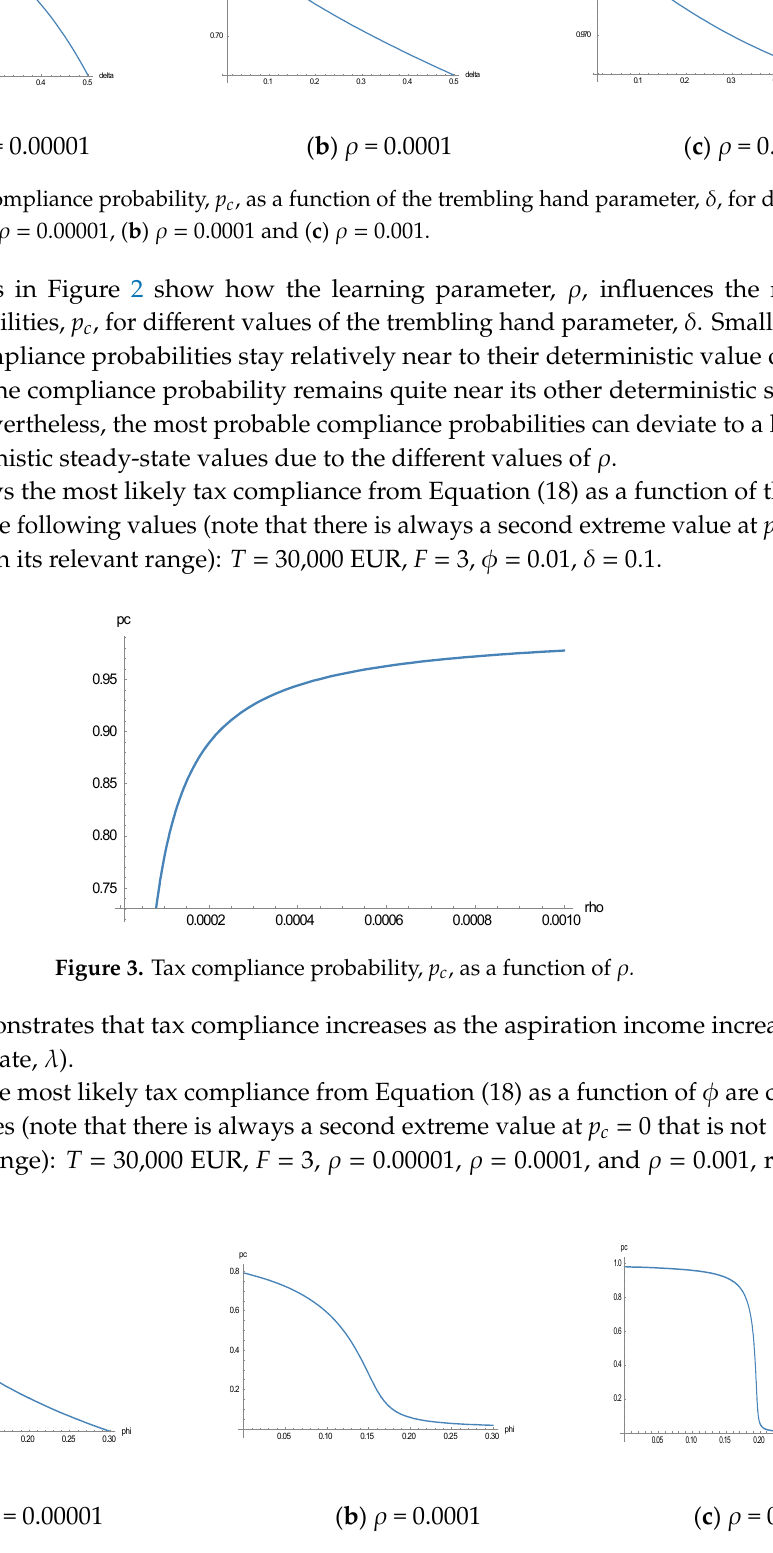
Figure 4. Tax compliance probability, p c , as a function of ϕ for different values of ρ : ( a ) ρ = 0.00001, ( b ) ρ = 0.0001 and ( c ) ρ = 0.001 .